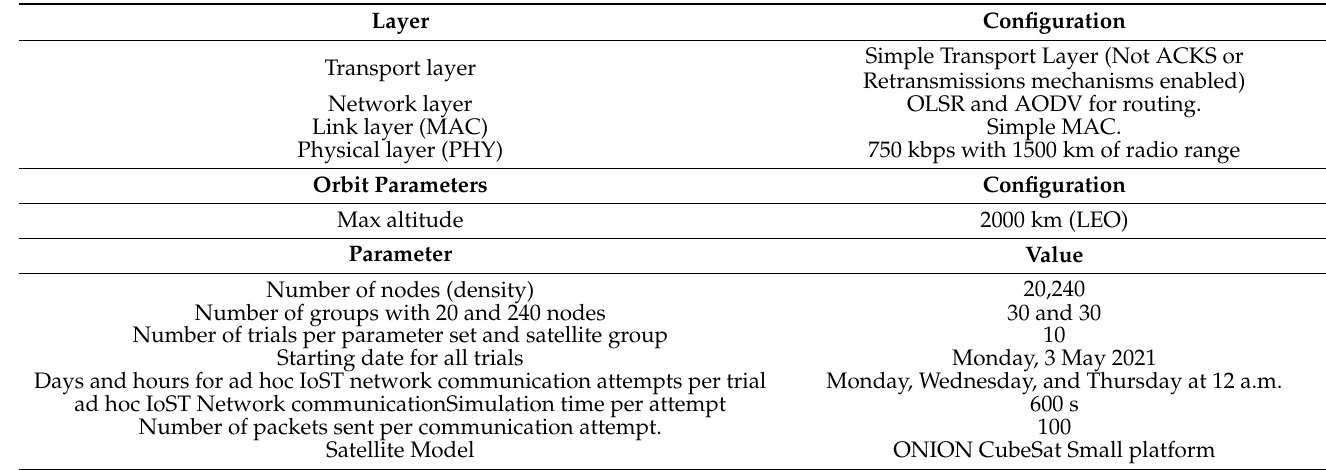
Table 1. Simulator